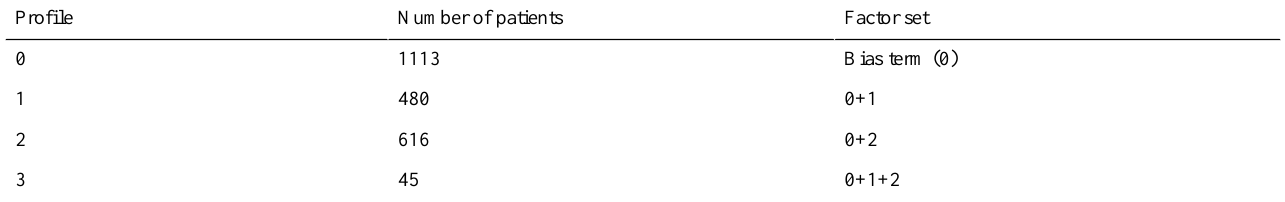
Table 1. Number of patients in each